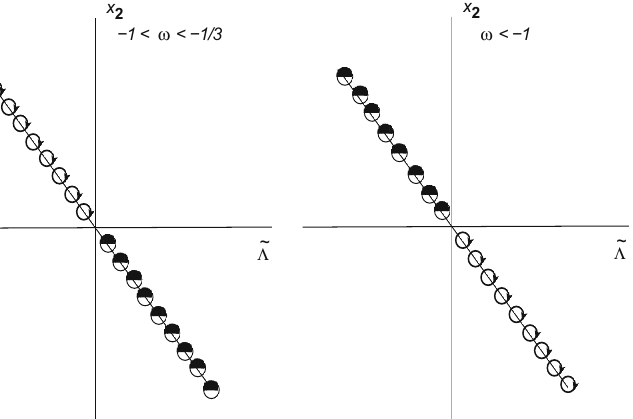
the range specified. The half-filled circle and arrowed circle represent ˜ (cid:4) a saddle and a center , determining the fixed 1 + 3 ω